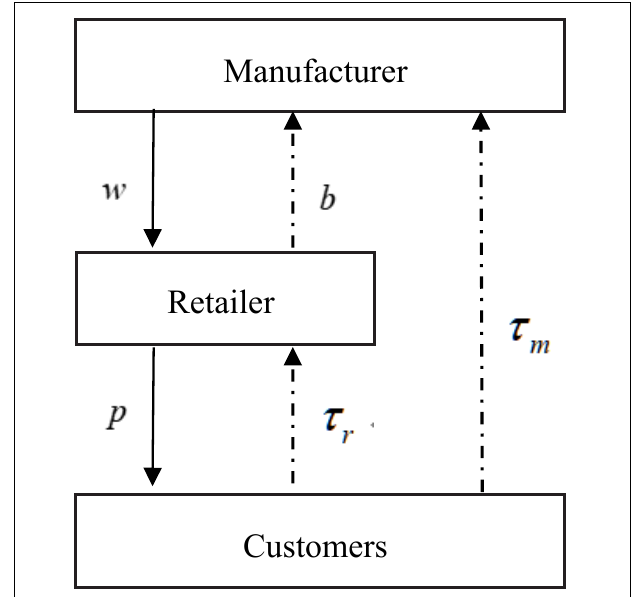
FIGURE 1 | The model structure diagram of this